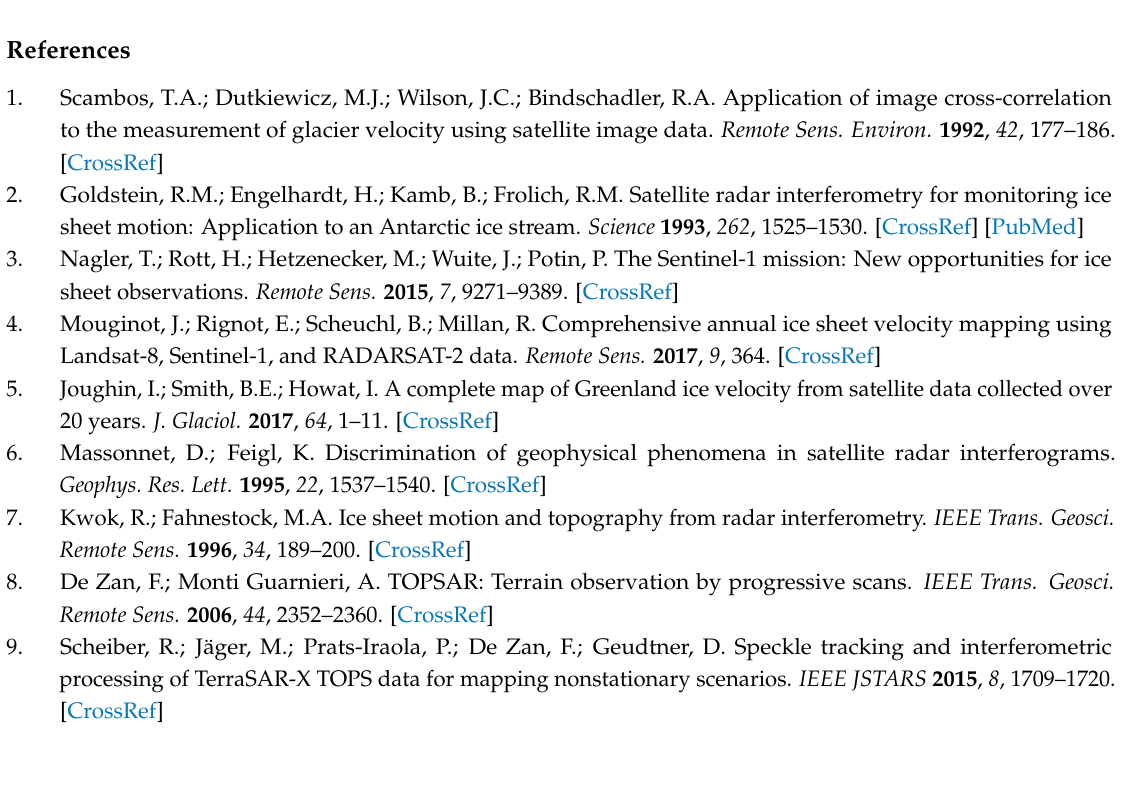
results, Table S4: Task 3 validation results, Table S5: Task 4 validation